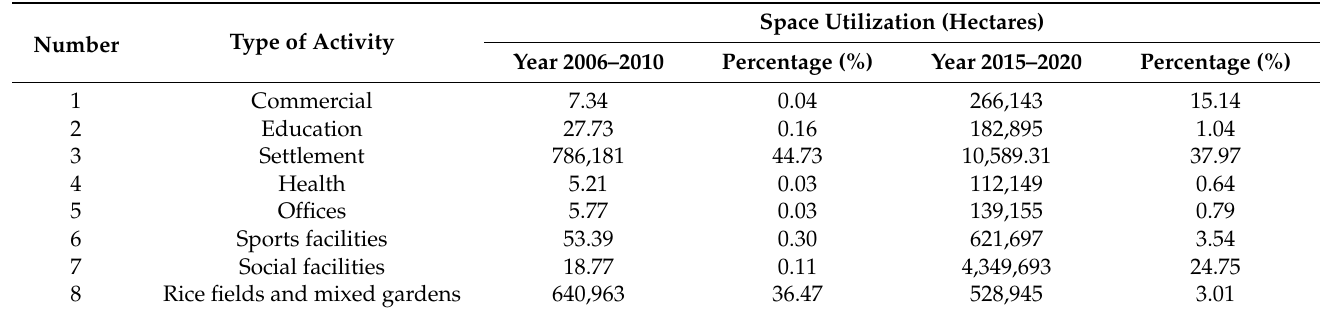
Table 4. Space utilization of Makassar City for the period